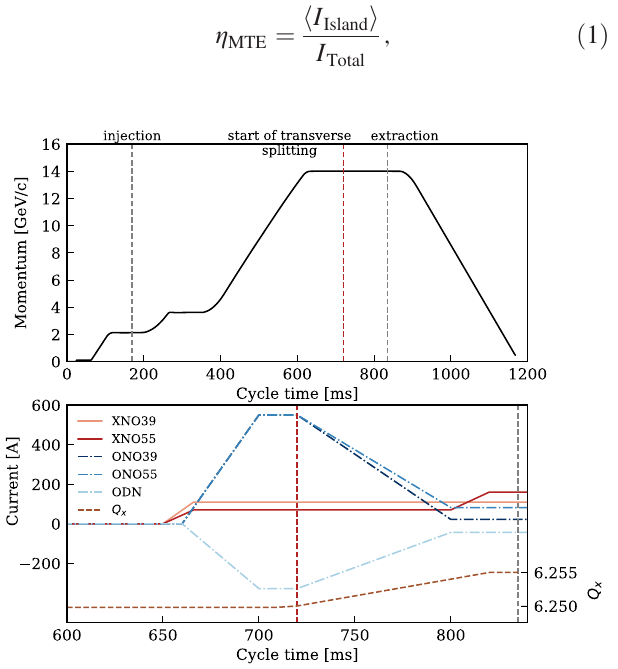
FIG. 2. Upper: Sketch of the PS magnetic cycle with the main events. Lower: Evolution of the strengths of the main MTE elements. The red vertical dashed line indicates the moment of resonance crossing and the grey one the